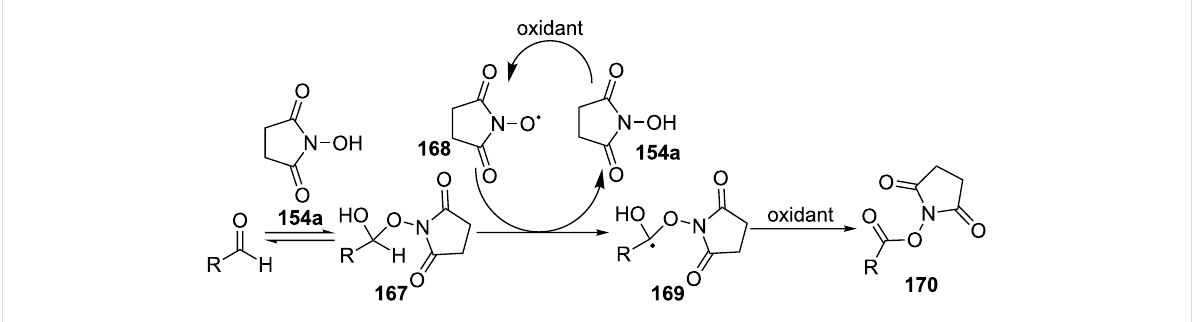
Scheme 34: Proposed mechanism of the oxidative coupling of aldehydes and N -hydroxysuccinimide under action of (diacetoxyiodo)benzene.